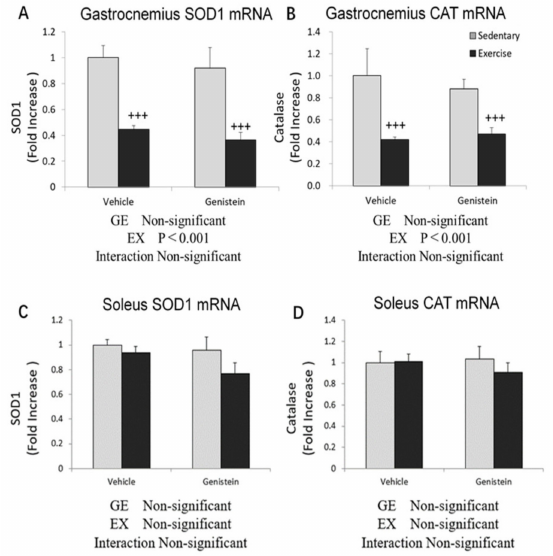
Figure 4. ( A ) Gastrocnemius SOD1 mRNA (Con, n = 7; GE, n = 8; Ex, n = 8; GE + EX, n = 8). ( B ) Gastrocnemius CAT mRNA (Con, n = 7; GE, n = 8; Ex, n = 8; GE + EX, n = 8). ( C ) Soleus SOD1 mRNA (Con, n = 7; GE, n = 7; Ex, n = 7; GE + EX, n = 7). ( D ) Soleus CAT mRNA (Con, n = 7; GE, n = 7; Ex, n = 6; GE + EX, n = 7). Vehicle: non-supplemented groups (only administrated with 0.5% CMC-Na solution). GE: GE-supplemented groups. +++ p < 0.001, the main effect of exercise. Values are means ±